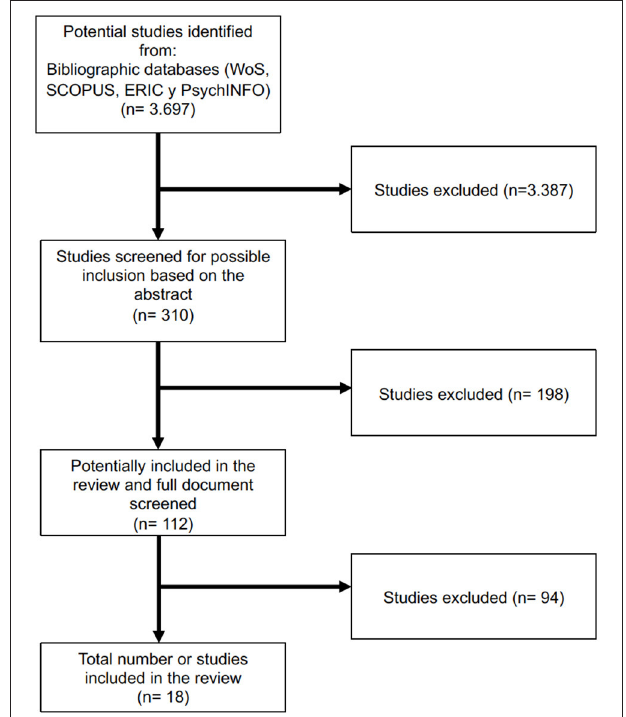
FIGURE 1 | Flow diagram to show the process of study